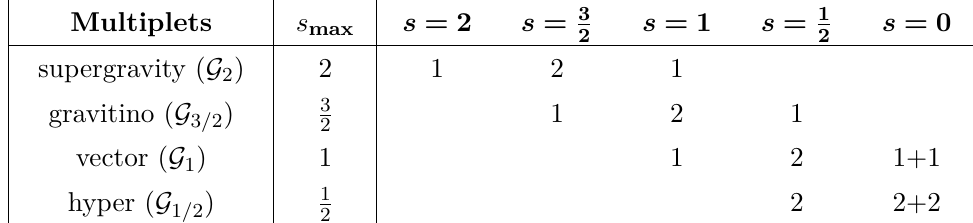
Table 1 . Different multiplets and spin content of a N = 2 , d = 4